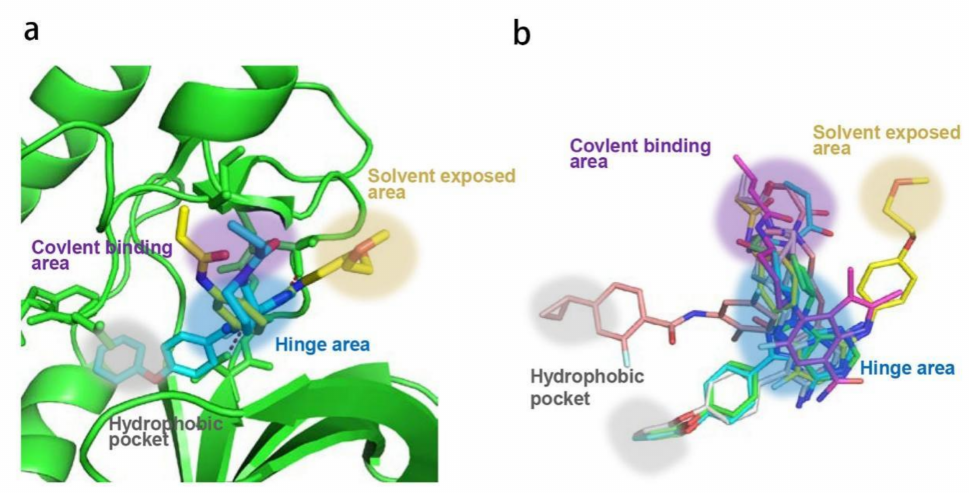
Figure 12. ( a ) The binding site of BTK complexed with ibrutibib (PDB code: 5P9J) is depicted with key regions highlighted by different shaded colors. The binding site is indicated in the green cartoon representation. Ibrutinib is shown as sticks and the carbon atoms are depicted in cyan. Key areas for ligand binding, such as the hydrophobic pocket (grey), covalent binding area (purple), the solvent-exposed area (light orange) and hinge area (light blue), are represented. For clarity, compound 16 from co-crystal complex (PDB code: 5P9L) was aligned to ibrutinib and its carbons are in yellow. ( b ) Superimposition of representative BTK inhibitors from crystallographic data within the binding site (Compound 1 , 8 , 16 , 15 , 17 , 18 ; PDB code: 5P9J, 5P9M, 5P9L, 6O8I, 6TFP, 6OMU). Inhibitors are shown as sticks in different colors. Key areas for ligand binding are highlighted as in ( a ). All structural images were created using PyMoL